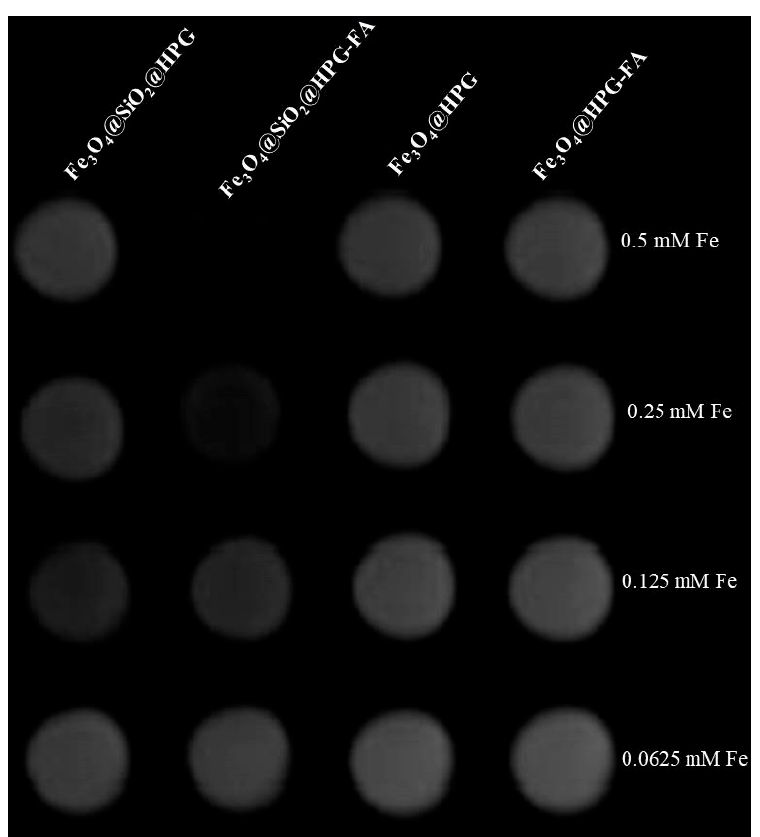
Figure 7. T 2 -weighted image of MCF-7 cells after they are treated with different concentrations Fe of each contrast agent.